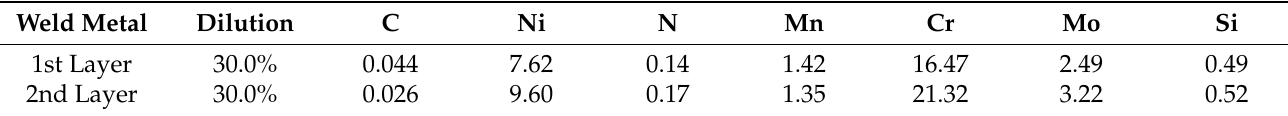
Table 4. Prediction dilution for alloying elements in each weld layer.